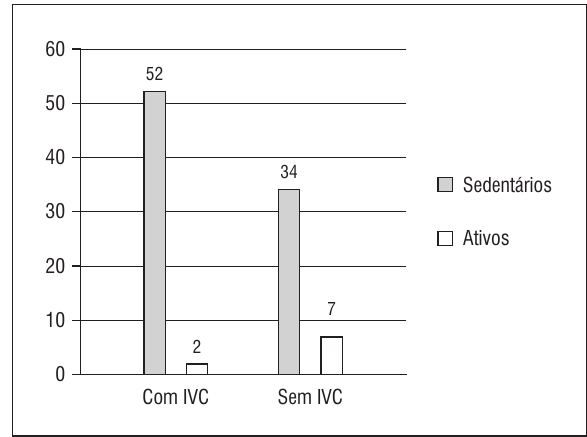
Figura 1 - Associação entre nível de atividade física e pre-